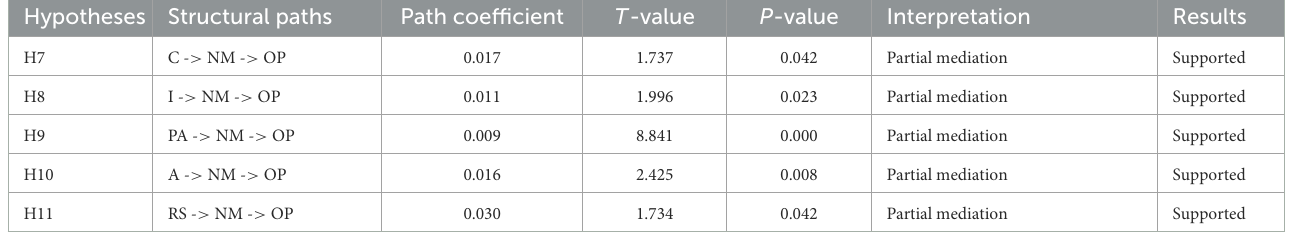
TABLE 8 Indirect effects.